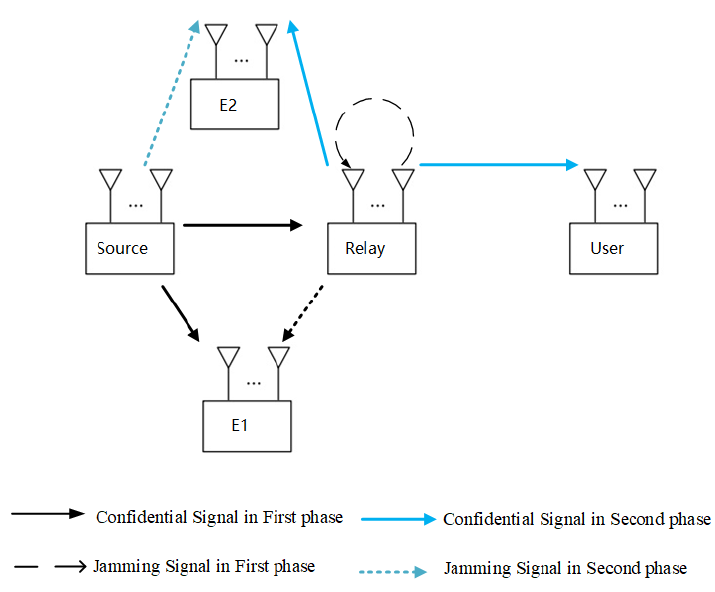
Figure 1. Wireless communication system model with a single